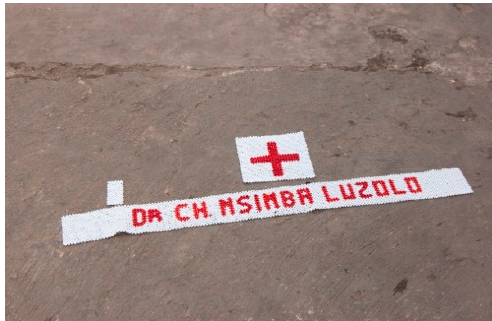
Figure 4. Decoration for a doctor’s office.